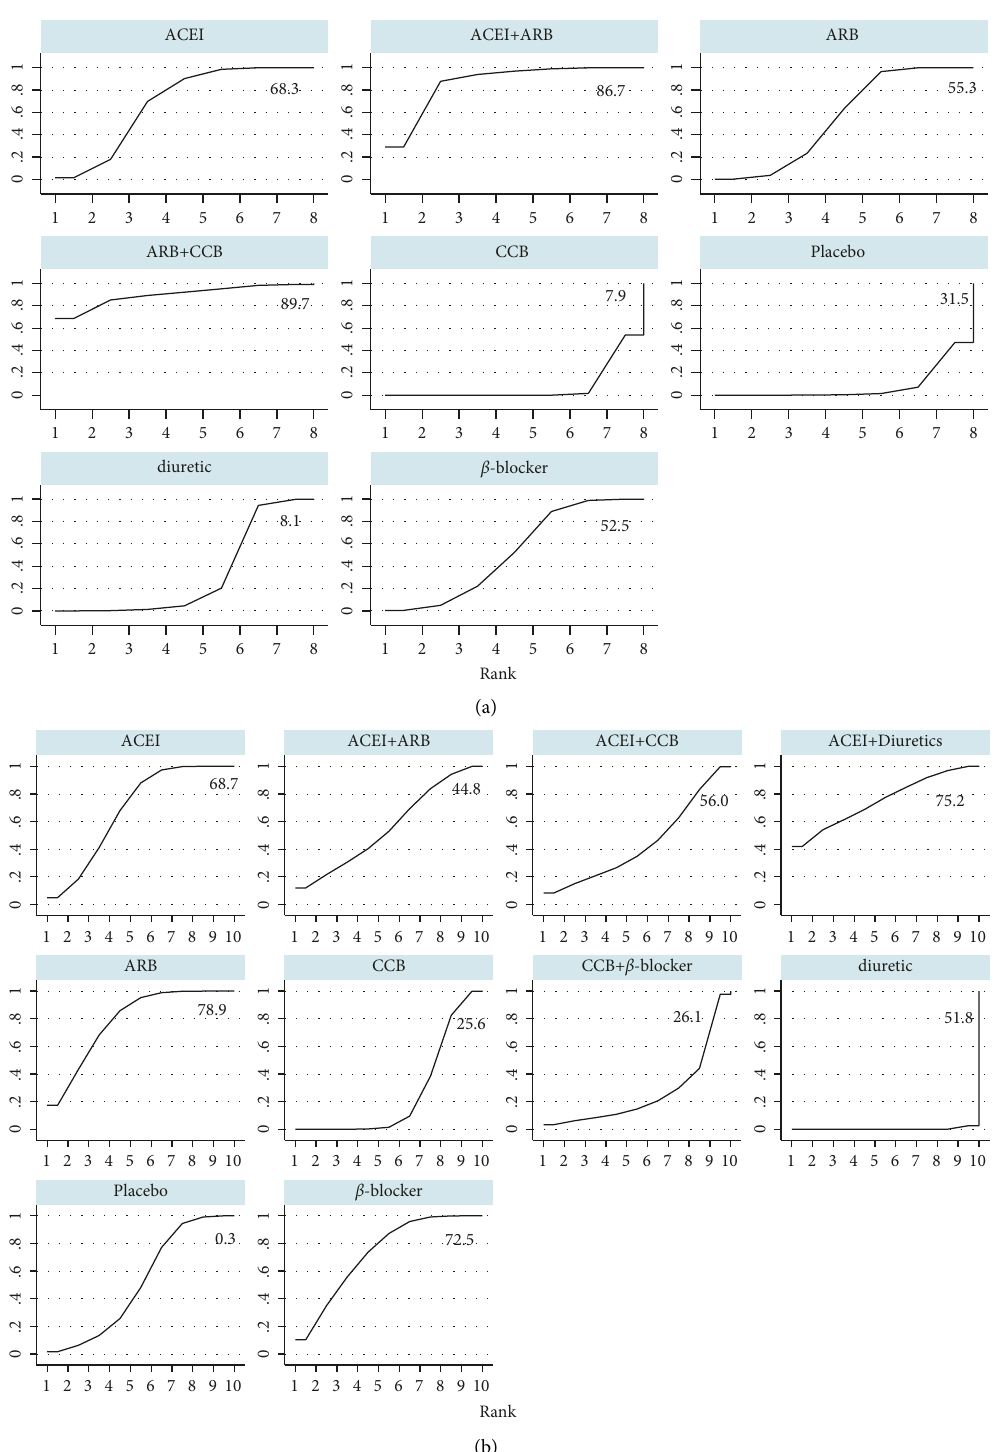
Figure 10: Subgroup analysis of cumulative ranking probability plot for the assessment of duration treatments in FMD. (a) Duration treatments ≤ 8 weeks, (b) duration treatments ＞ 8 weeks) ACEI: angiotensin-converting enzyme inhibitors, ARB: angiotensin receptor blocker, CCB: calcium channel